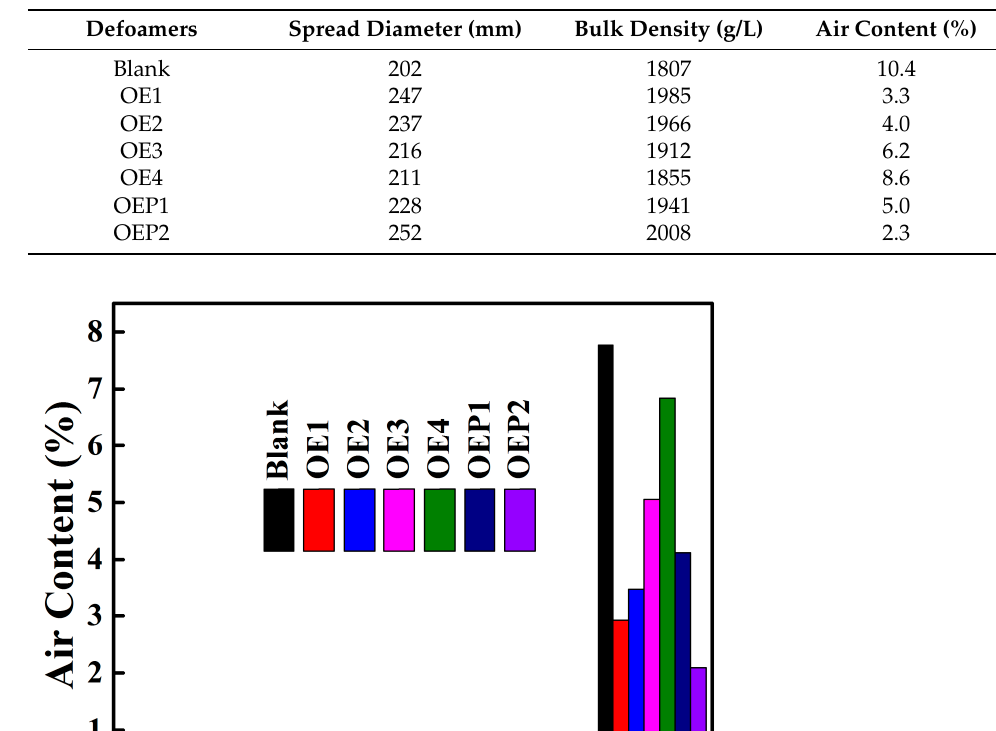
Table 5. Performance of the hardened mortar samples mixed with various defoamers.